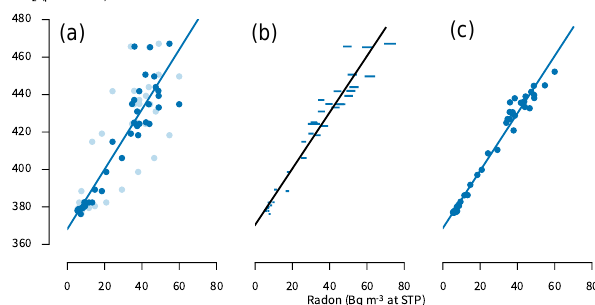
Figure 8. Correlation between radon and carbon dioxide concentra- tions during the same night as Fig. 7. In panel (a) , raw light points indicate raw data and heavy points have the radon time series lagged by 1hour (the linear fit is for the lagged points). In panel (b) , radon measurements have been deconvolved to correct for the detector re- sponse and the horizontal bars show the range between 10th and 90th percentiles. Panel (c) shows the raw radon measurements ver- sus carbon dioxide concentrations which have been filtered with a running mean filter weighted by the radon detector response. The slopes of the three linear fits are (a) : 1.60, (b) : 1 . 50 ± 0 . 07, (c) : (cid:16) (cid:17) (cid:16) (cid:17) / 1.53 umolmol − 1 Bqm − 3 STP